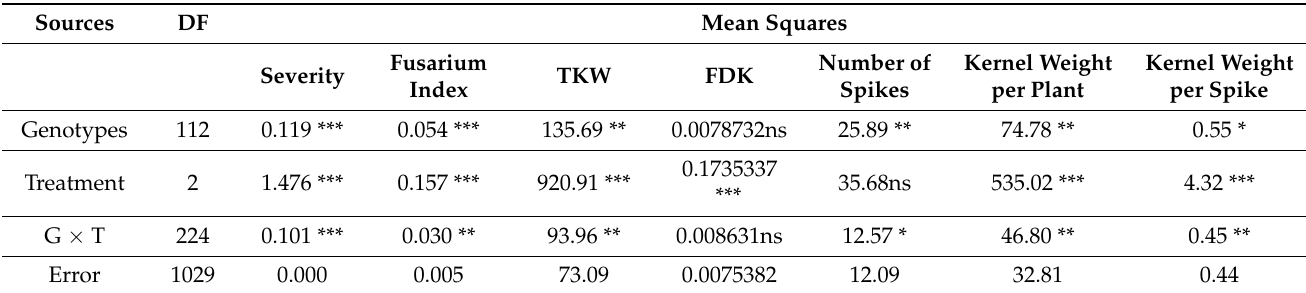
Table 1. ANOVAs for Severity, Fusarium Index, thousand kernel weight (TKW), Fusarium damaged kernels (FDG), number of spikes, kernel weight per plant and kernel weight per spike in ITMI/MP lines inoculated with F. graminearum for Type I and II of resistance and in the control plants. *, ** and *** indicate significant differences at p -values < 0.05, 0.01 and 0.001,